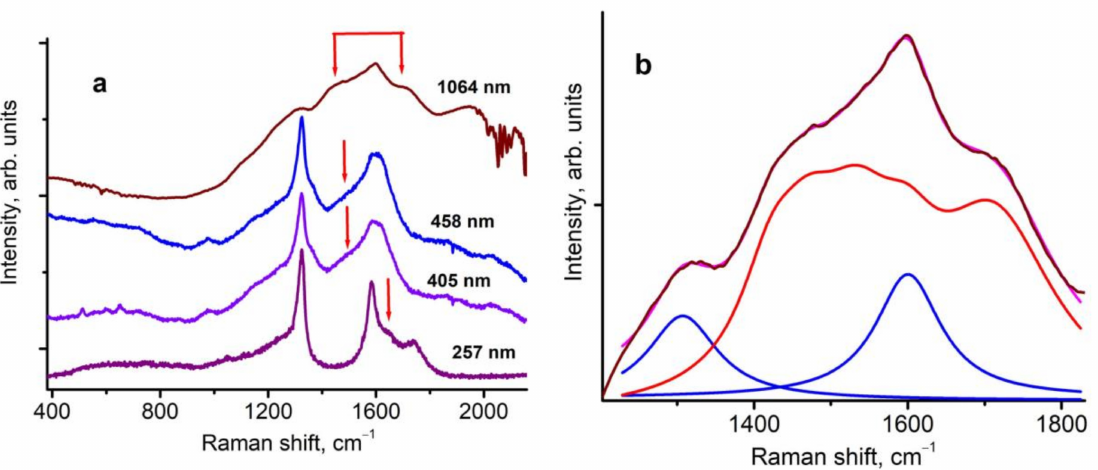
Figure 1. Raman spectra of the studied 2–5 nm nanodiamonds encapsulated in NaCl. ( a ) Raman spectra measured with four different excited wavelengths in the region of 257–1064 nm; red arrows mark the dispersive band position. ( b ) Lorentz multi-peak fits of Raman spectrum excited with 1064